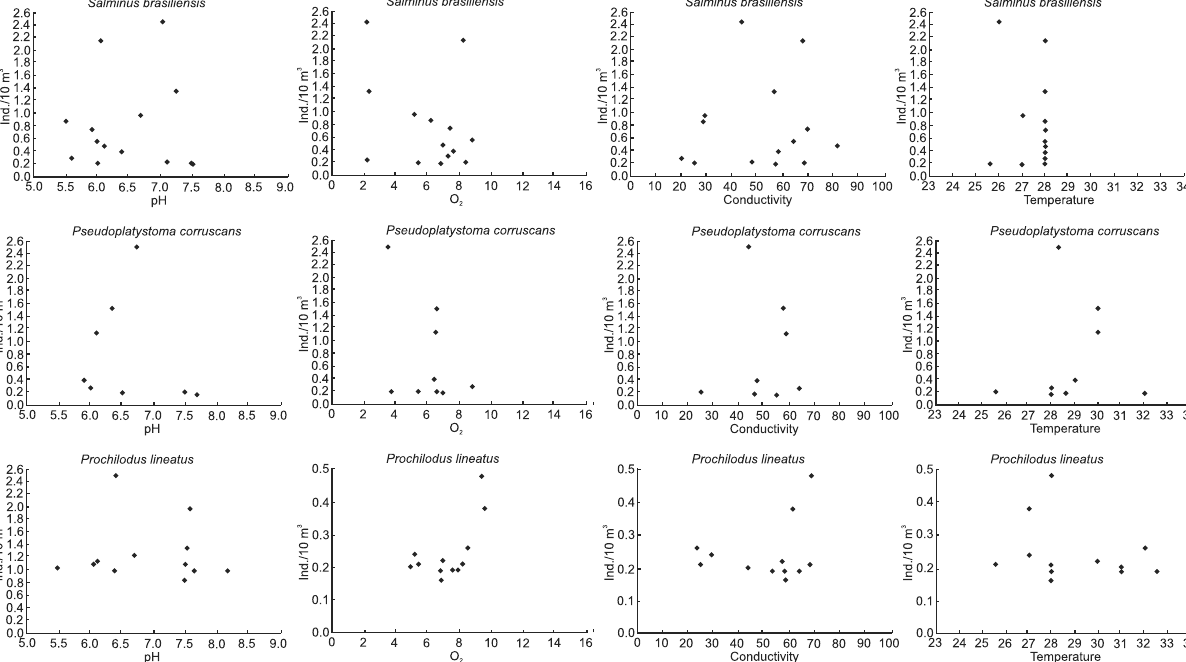
Figure 10. Relationship of environmental variables with densities of Salminus brasiliensis , Pseudoplatystoma corruscans and Prochilodus lineatus in the Upper Paraná River